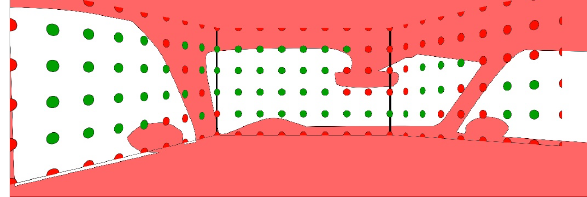
Figure 12: The red overlay indicates the occlusions by the vehicle chassis. Reference points and feature changes were only placed on green positions, to be well visible from the driver’s positions.